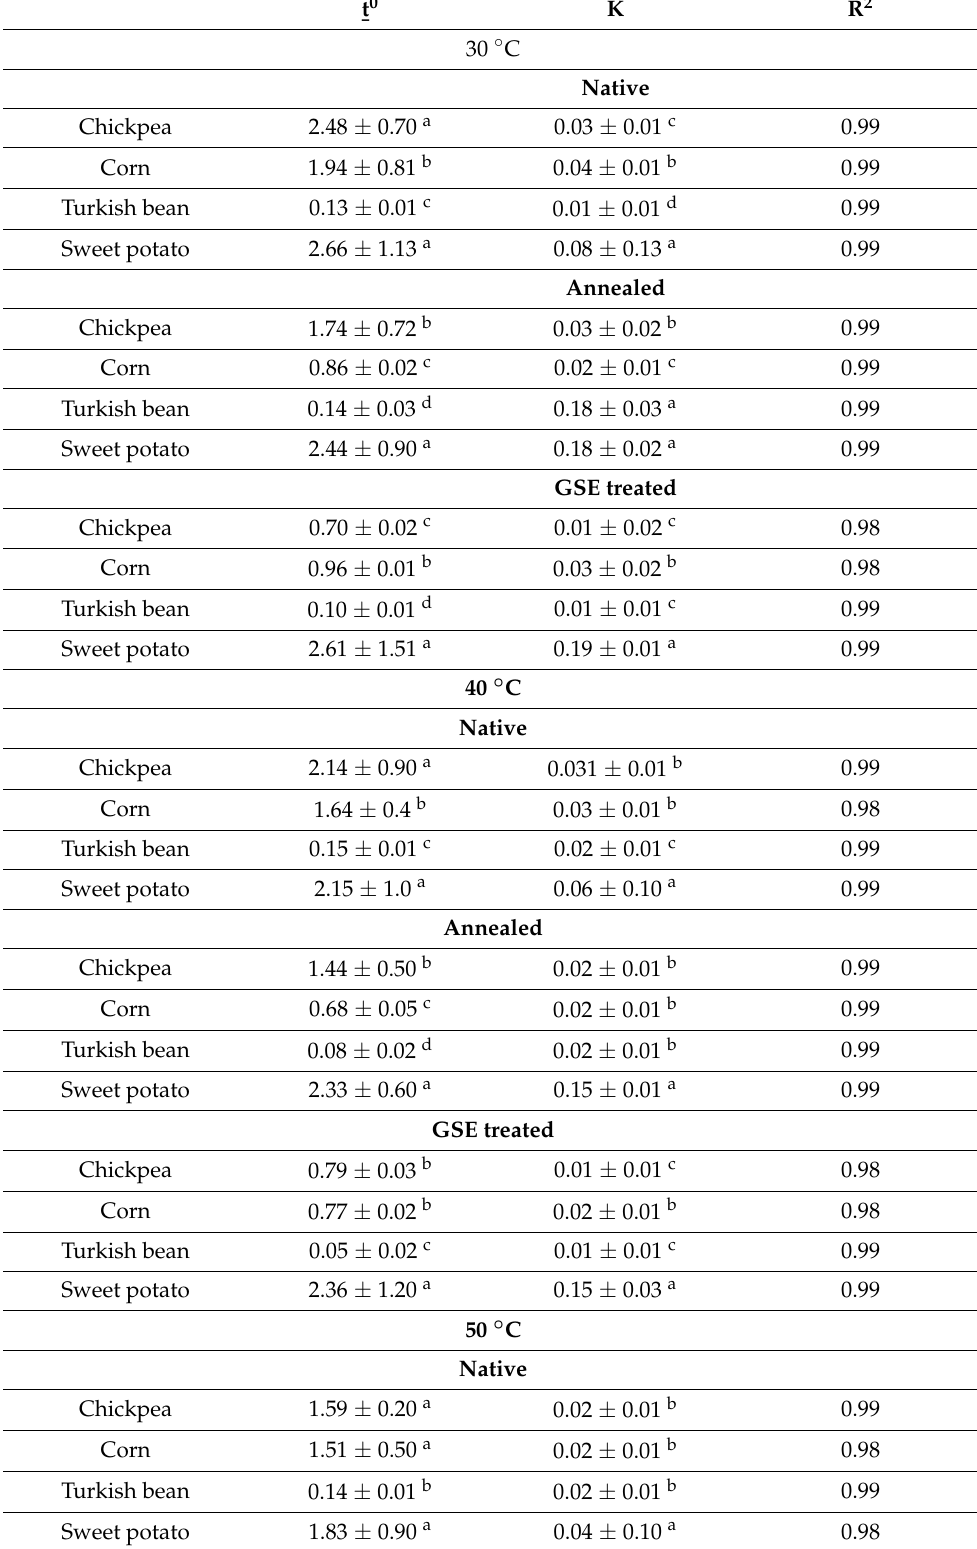
Table 3. Effect of annealing and germinated sorghum extract on Casson model parameters (T 0 , K ) of chickpea, corn, Turkish bean and sweet potato starches tested at 30 ◦ C and 40 ◦ C, consistency index ( K ), flow behavior ( n ) index and the yield stress (T 0